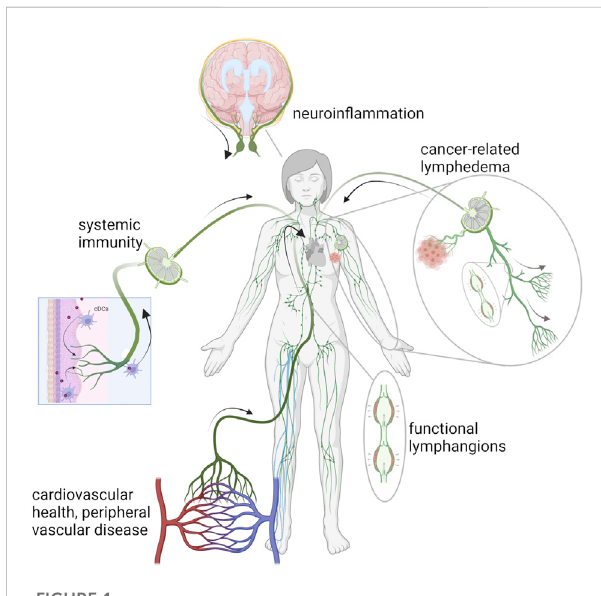
FIGURE 1 Schematic of the lymphatic vasculature in chronic conditions associated with autoimmunity, chronic venous disease, lymphedema, and neuroin fl ammation. Created with